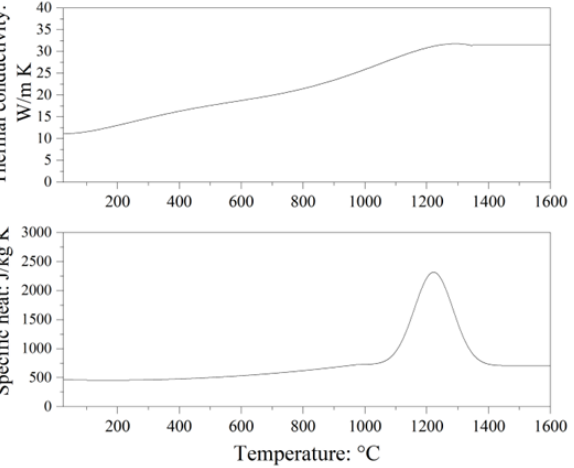
Figure 5. The specific heat and thermal conductivity of Inconel738 LC used in the FEM